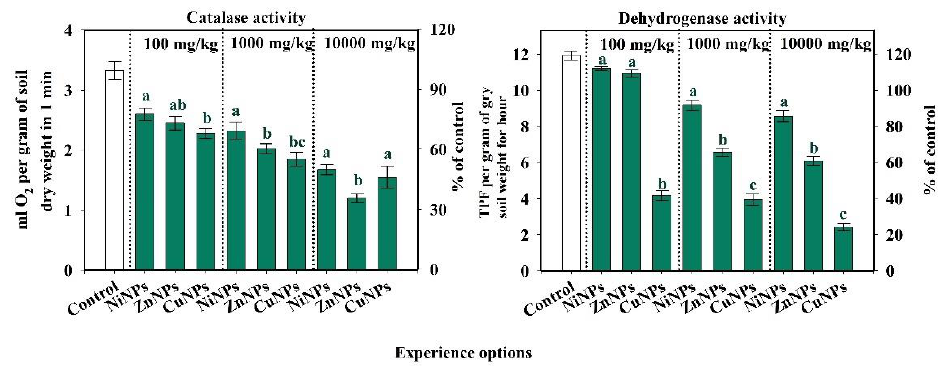
Figure 2. Changes in catalase and dehydrogenase activity of Cambisols by CuNPs, NiNPs, and ZnNPs pollution. Note: Different letters indicate significant differences ( p < 0.05) between the content of nickel, zinc, and copper nanoparticles at the same dose of their introduction into the soil, obtained as a result of the Student’s test.